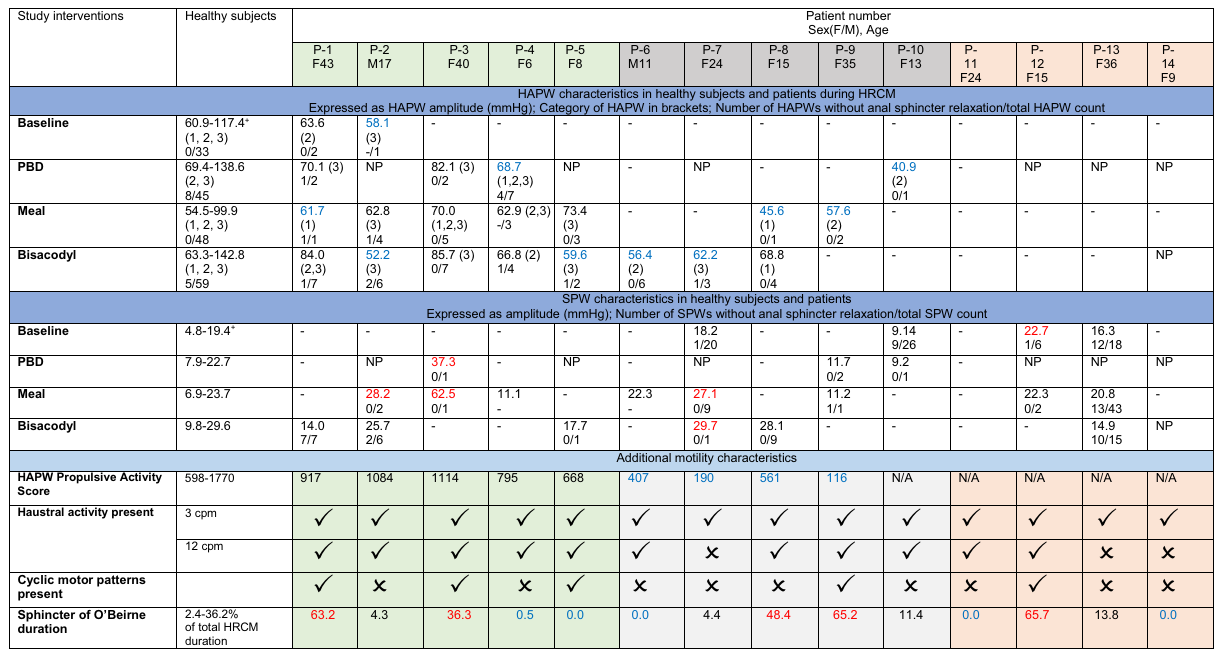
Table 1. Motility characteristics of all patients in comparison with healthy subjects. HAPW high-amplitude propagating pressure waves, SPW simultaneous pressure waves, HRCM high-resolution colonic manometry. NP indicates intervention not performed, “−” indicates no appearance. + Healthy control range of HAPW and SPW amplitude = mean ± 1SD; derived from previous studies 16, 20 . Control SPW amplitude for bisacodyl includes both proximal colon and rectal administrations. HAPW categories: 1 = HAPW that originates in the ascending colon 2 = HAPW that starts in the ascending colon and terminates in the transverse, or descending, or sigmoid colon, or may reach the rectum 3 = HAPW that originates at the transverse or descending colon 20 . HAPW propulsive activity of healthy subjects (N = 11) were derived from healthy subjects who received the same interventions 20 . Normal anal relaxation was defined as relaxation of > 30% in anal sphincter pressure for HAPWs, and > 25% for SPWs 16, 20 . Blue font = value is lower than 1 standard deviation of healthy control mean. Red font = value is higher than 1 standard deviation of healthy control